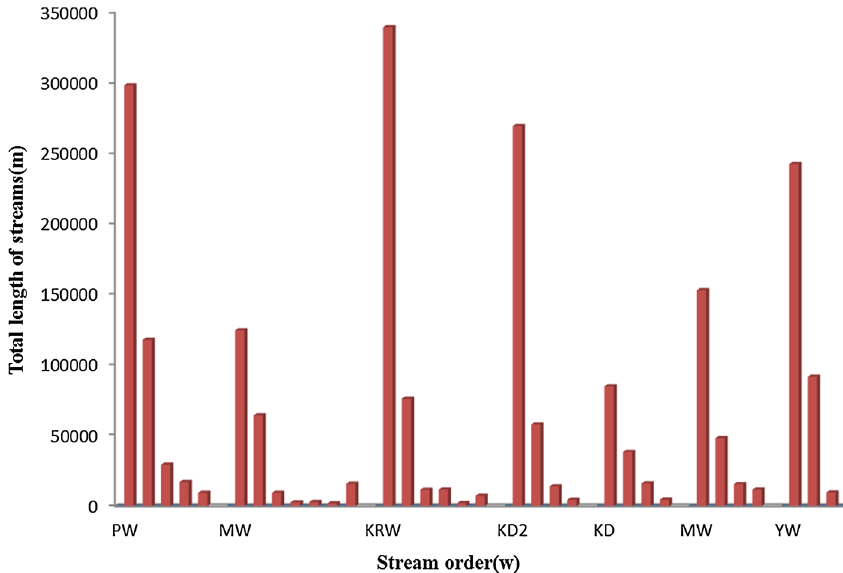
Fig. 3 Variation of the stream order versus total length of